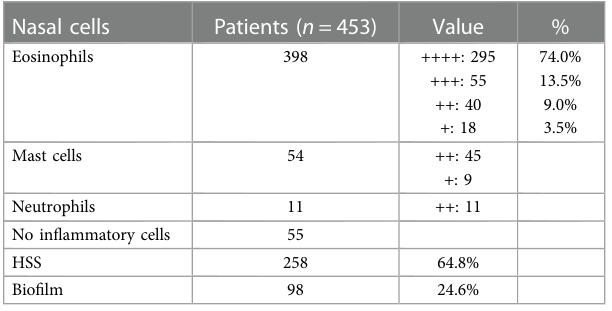
TABLE 3 Nasal cytology